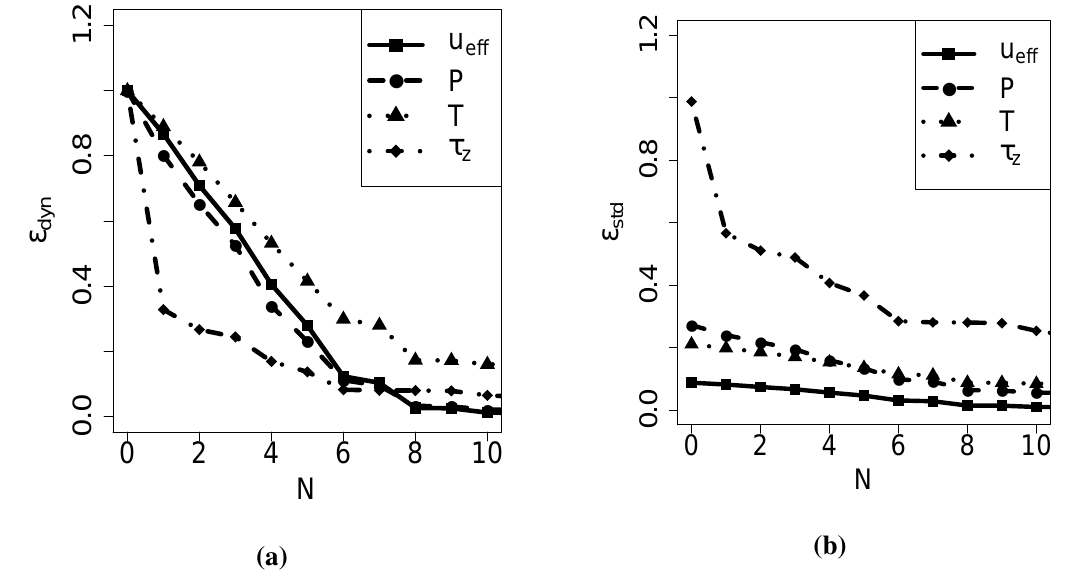
Figure A2. ( a ) Dynamical and ( b ) standard error for different measures versus the number N of modes used for the reconstruction. N = 0 corresponds to a reconstruction with the mean field